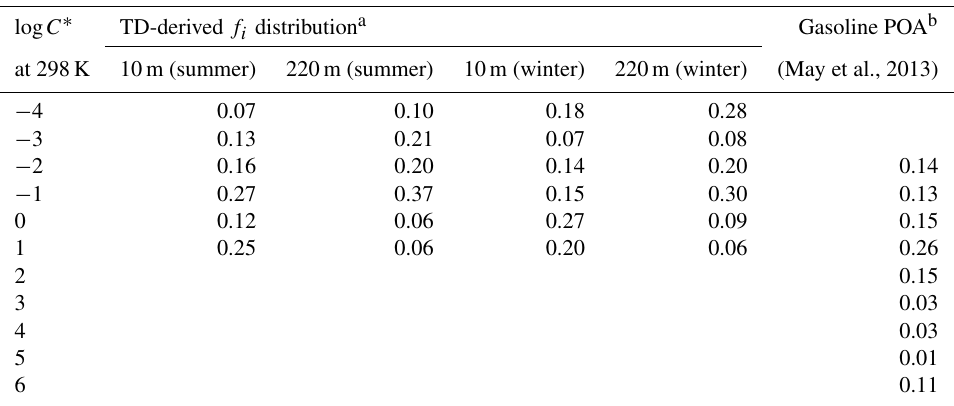
Figure 6. Campaign-average measured (points) and modeled (line) thermograms for different sized particles measured at 10 and 220m downwind during summer (a–b) and winter (c–d) . Model lines are shown using the best-fitted volatility distributions listed in Tables 1 and S2; (cid:49)H vap = 100KJmol − 1 and γ e = 0 . 25. Table 1. TD-derived particle volatility distributions (at 298K) at 10 and 220m of downwind distance from the highway I-40 during summer and winter. Laboratory-derived gasoline POA distribution by May et al. (2013a) is also